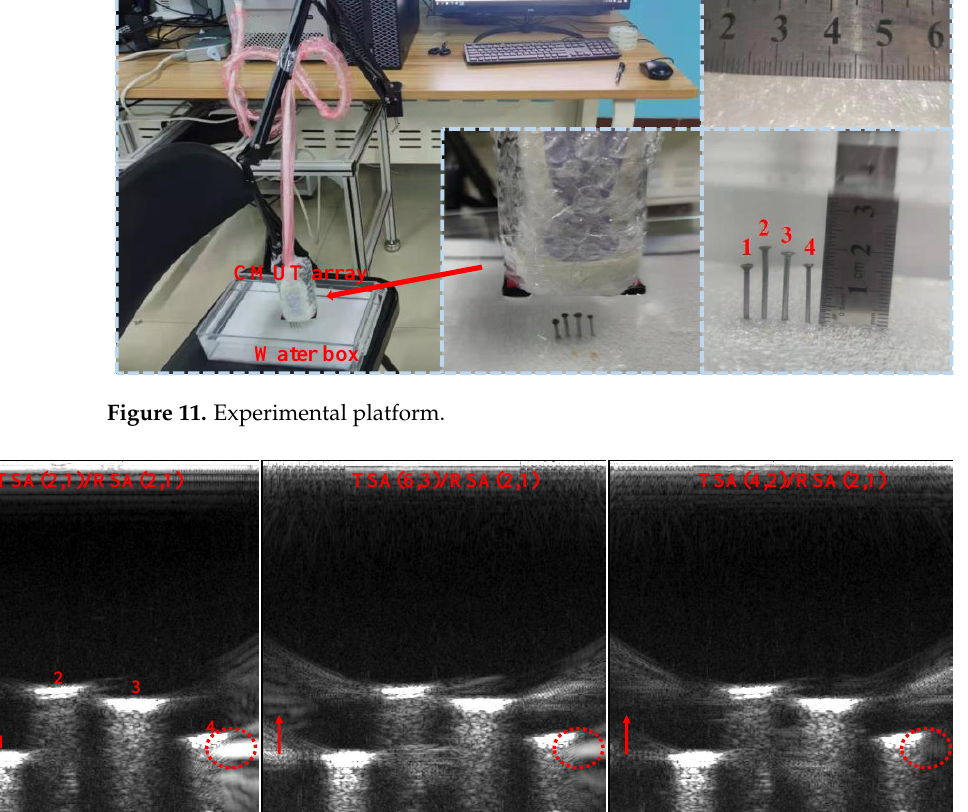
Figure 12. Imaging results of different CMUT sparse array configurations ( SF two − way =